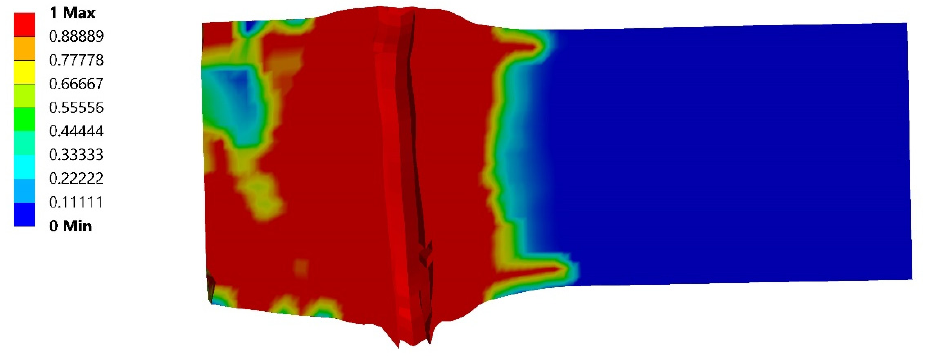
Figure 8. Damage—35 ◦ tip angle-AoA 90 ◦ , projectile passing through the target. Figure 8. Damage—35° tip angle-AoA 90°, projectile passing through the target. Figure 8. Damage—35° tip angle-AoA 90°, projectile passing through the target. For this case, the 180 ◦ tip shows the highest value, which can be concluded through For this case, the 180° tip shows the highest value, which can be concluded through the fact that a flat tip creates more damage than a sharp tip, which passes easier through the material. The data for a round tip does not really follow the trend of the other tip contours for a low AoA. This can be explained by this tip being able to dig in slightly under the top surface of the target and penetrating further through the target, more than the other tip contours, before also leaving the target towards the top. As there is no published research